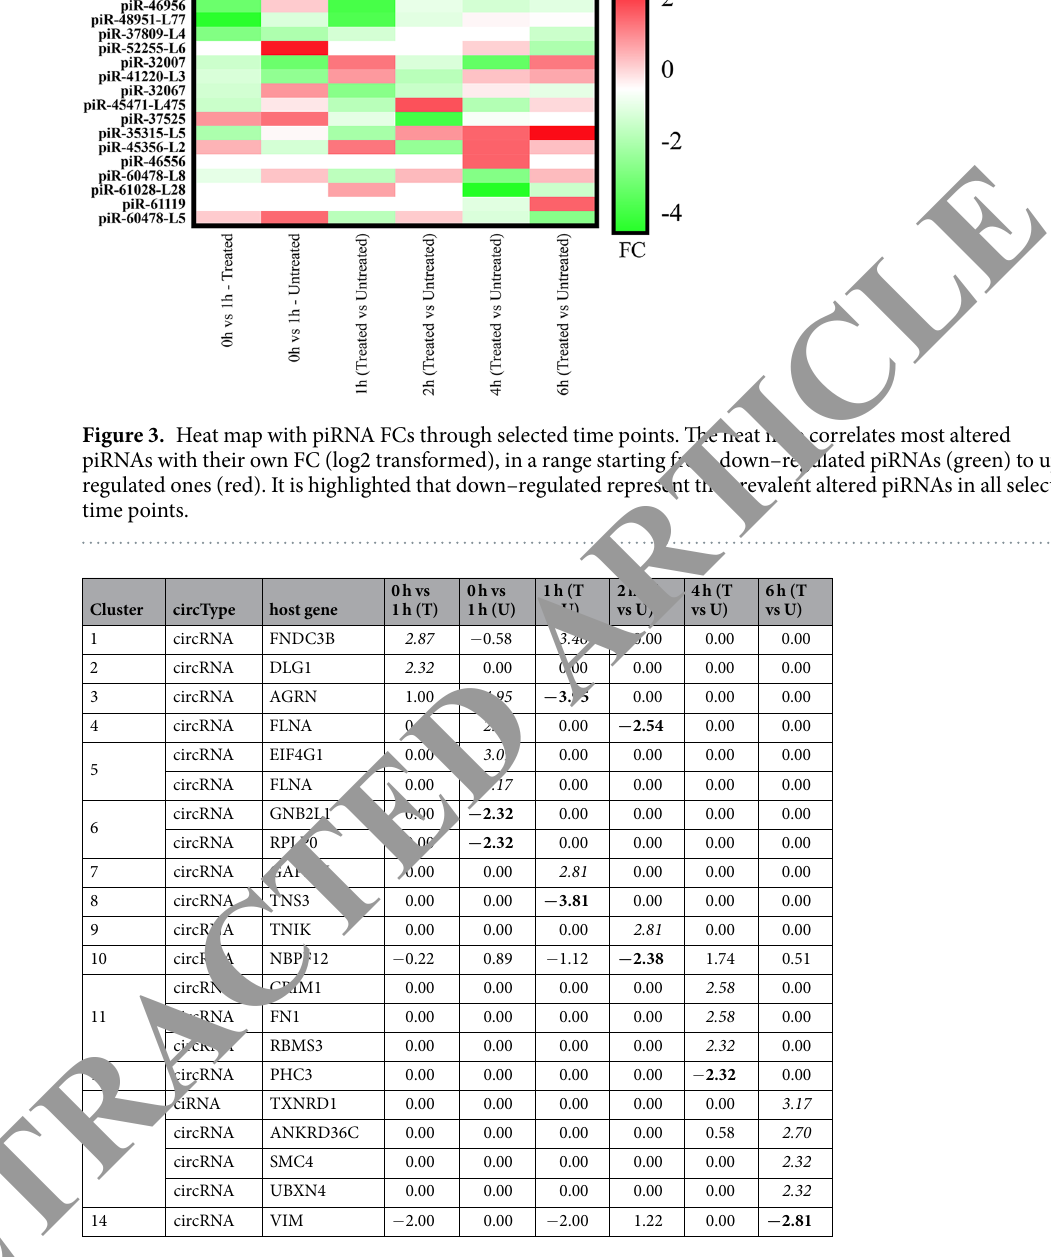
Table 1. Cluster analysis of differentially expressed circular RNAs. All significant differentially expressed circular RNAs were clustered by similarity of fold change trends. Italic FCs represent selected up–regulated circRNAs (FC > 2), while bold ones indicate down–regulated circRNAs (FC < − 2, considering the replacement of original FC value by its negative reciprocal value, in order to make the variation more noticeable). T = Treated sample. U = Untreated sample.